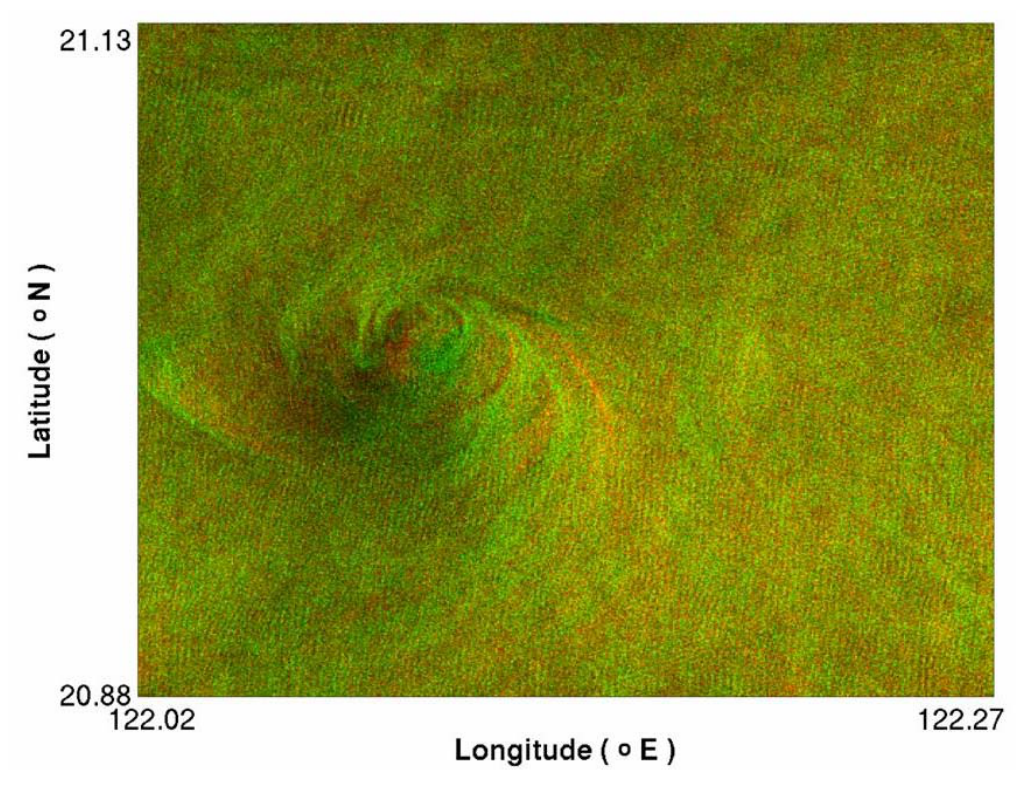
Figure 4. Overlay of the two SAR subscenes of eddy collected over the Luzon Strait near Philippines from ERS-2 (in green), and ENVISAT (in red) on April 27, 2005 separated by 28 minutes. The subscene coverage area is indicated by a small blue box in Figure